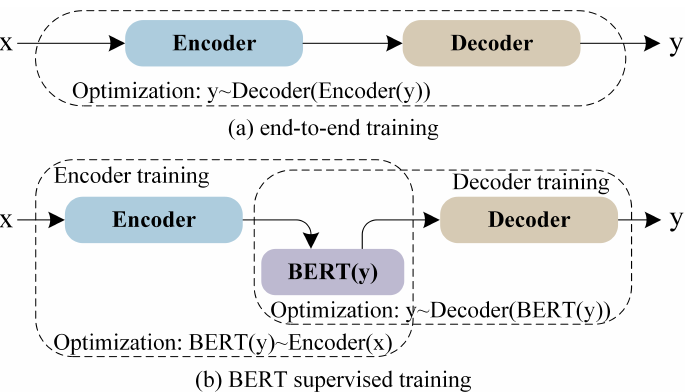
Figure 2. Illustration of end-to-end training and BERT supervised training of the Transformer. The facts are Capacity(Encoder) (cid:28) Capacity(Transformer) and Capacity(Decoder) (cid:28) Capac- ity(Transformer).